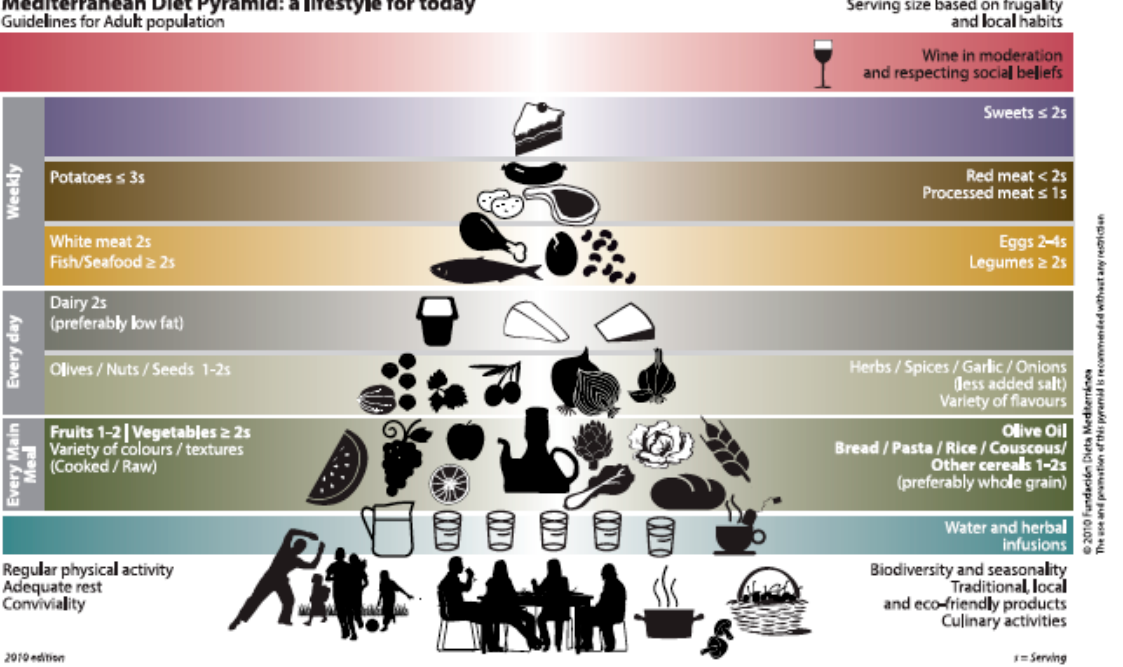
Figure 1. Pyramid of the Mediterranean diet (https://dietamediterranea.com/en/fundacion, accessed on 1 September 2021).